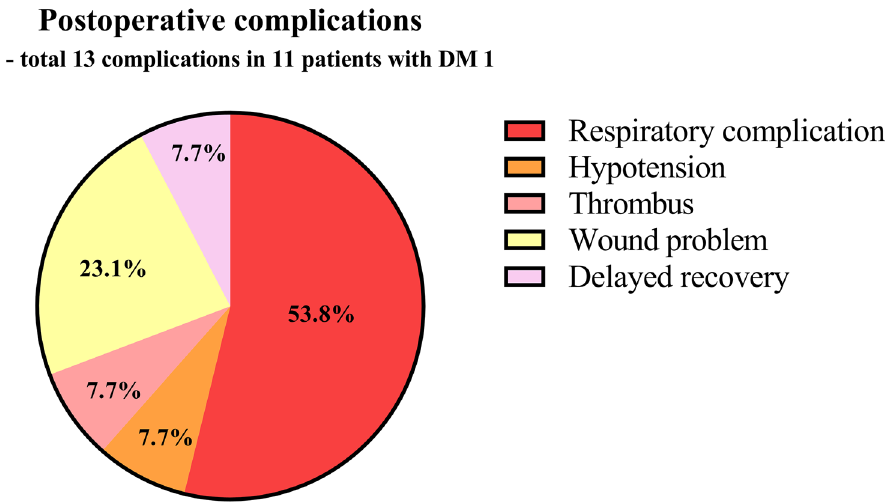
Figure 1. Detailed postoperative complications in patients with myotonic dystrophy type